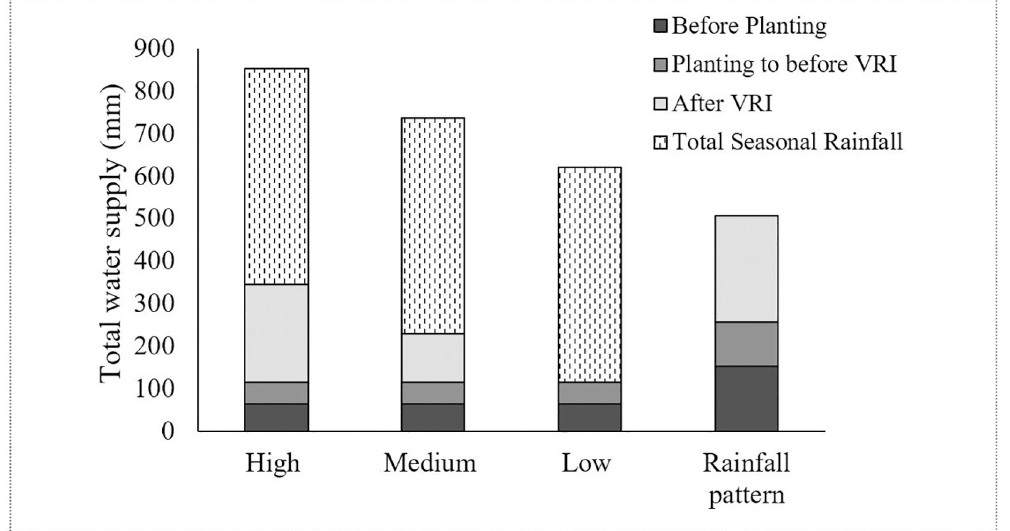
Fig 10. Pre- and in-season irrigation and rainfall for a 194-ha farm in Hale County, Texas in 2017.